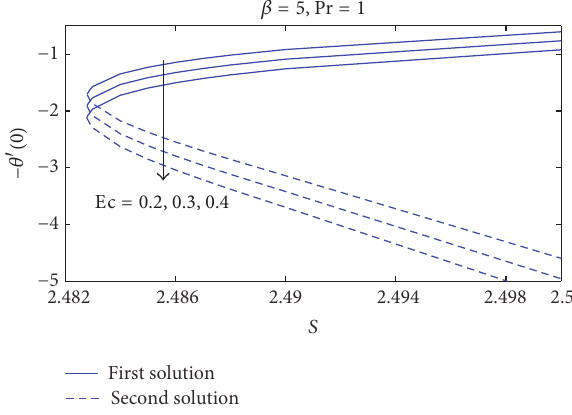
Figure 2: Skin friction coefficient 𝑓 󸀠󸀠 (0) with 𝑆 for different values of 𝛽 .